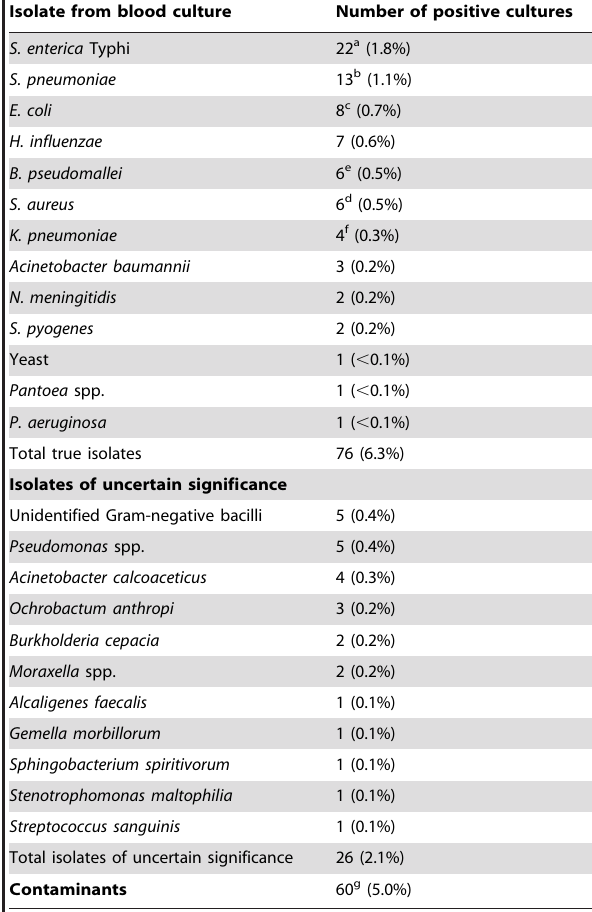
Table 4. Isolates from blood cultures ( n =1212).